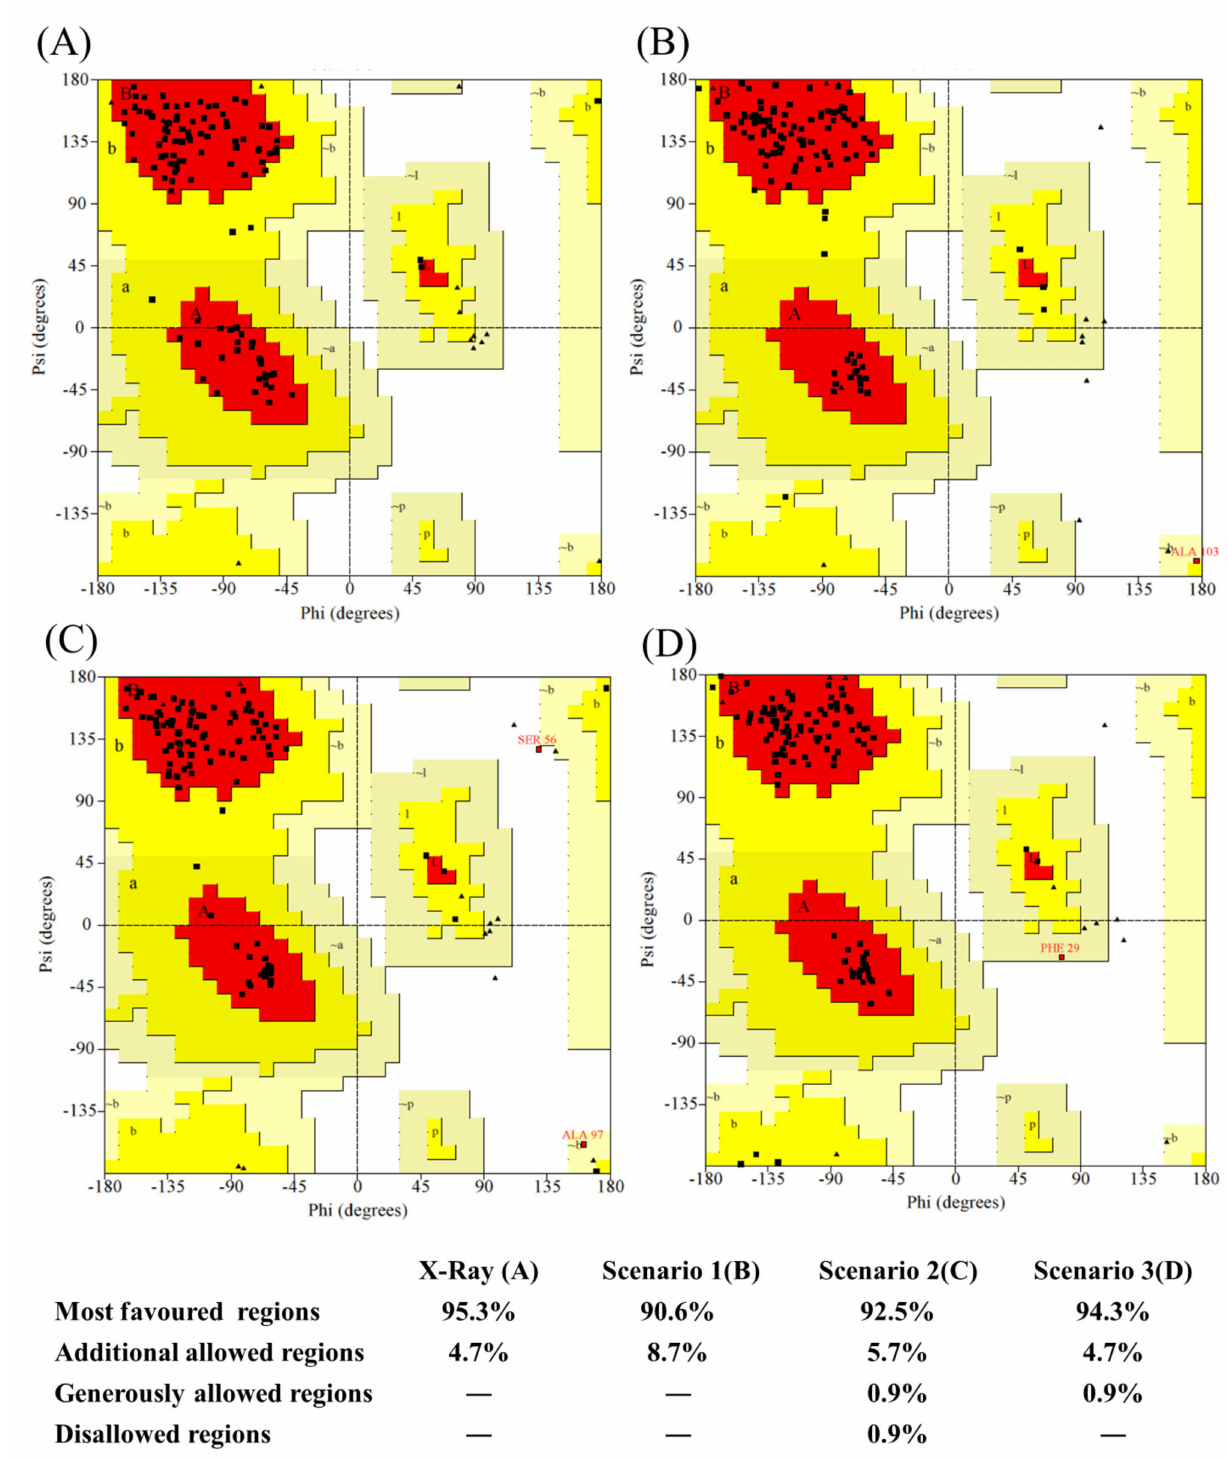
Figure A11. Ramachandran map distribution of residues. ( A ) 5E7B:A crystal structure, ( B ) best model from scenario 1 ( bestseqIdTemp ), ( C ) best model from scenario 2 ( beststructTemp ), and ( D ) best model from scenario 3 ( 3bestseqIdTemp